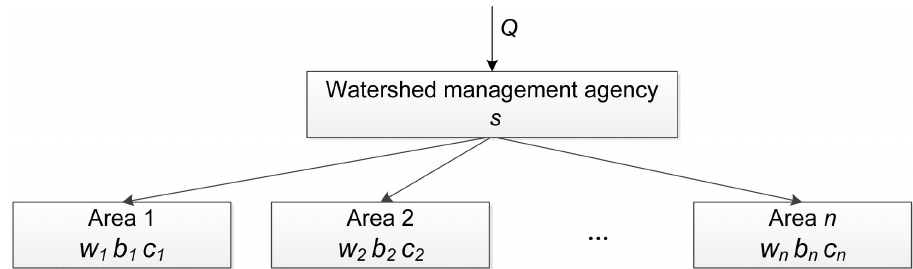
Figure 3. The specific generalization of water resources allocation.